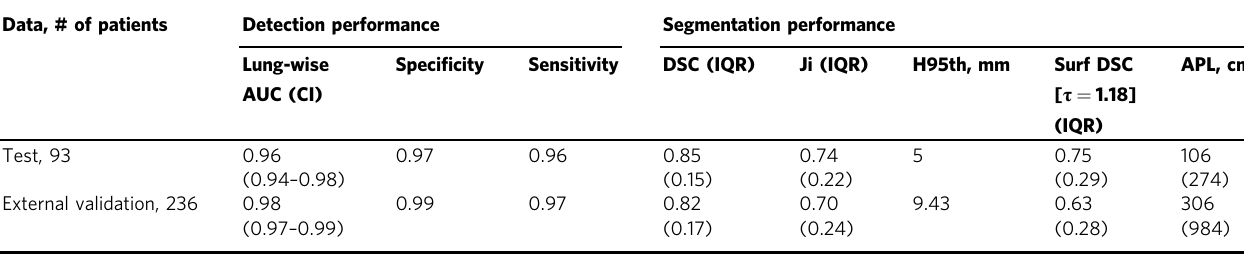
Table 2 Overview of quantitative model performance.